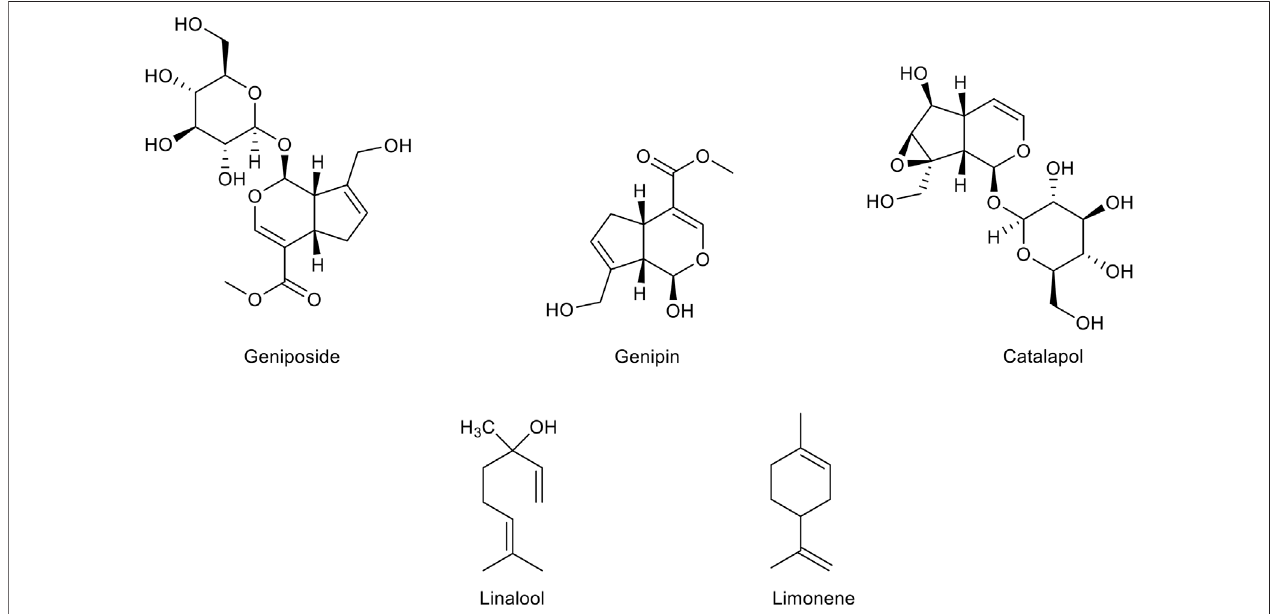
FIGURE 4 | Chemical structure of the main monoterpenes with a therapeutic potential for Alzheimer ’ s disease